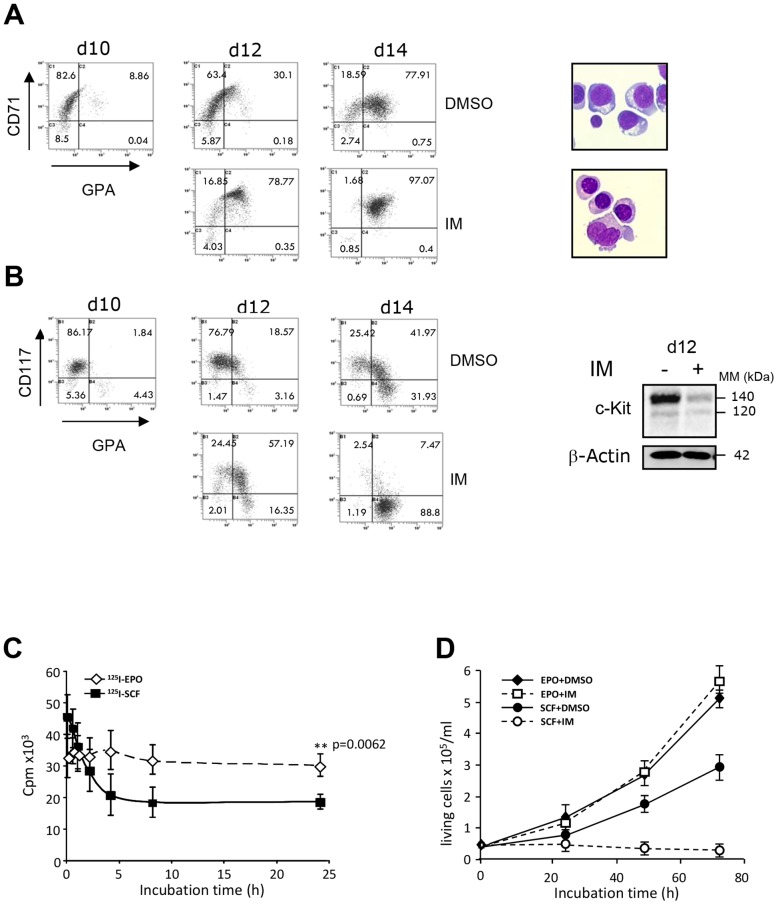
Imatinib induces the differentiation of human normal erythroblasts and decreases cell surface expression of c-Kit.Imatinib (2 µM) was added for 4 days to a culture of CD34+ cells-deriving erythroblasts. A. Effect of imatinib on erythroblast differentiation. Left panel: Flow cytometry for CD71 and GPA markers. Right panel: May Grunewald Giemsa staining at Day 14 (d14). B. Effect of imatinib on c-Kit expression Left panel: Flow cytometry for CD117 and GPA. Right panel: Immunoblot for c-Kit. C. Expression of functional c-Kit at cell surface. UT-7/Epo cells were incubated with 2 µM imatinib, or vehicle at 37°C for indicated times, and labeled with 200 ng/ml [125I]SCF or 1 UI/ml [125I]Epo for 90 min at 4°C. Cell surface-associated radioactivity was counted. Results are the mean of at least three independent experiments. D. UT-7/Epo cell proliferation in response to SCF. UT-7/Epo cells were incubated with 1 UI/ml Epo or 50 ng/ml SCF, in the presence or absence (vehicle) of 2 µM imatinib (IM). At the indicated times, cells were counted in triplicates.